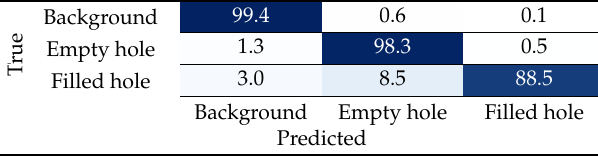
Table 3. Confusion matrix for classifying empty and filled holes